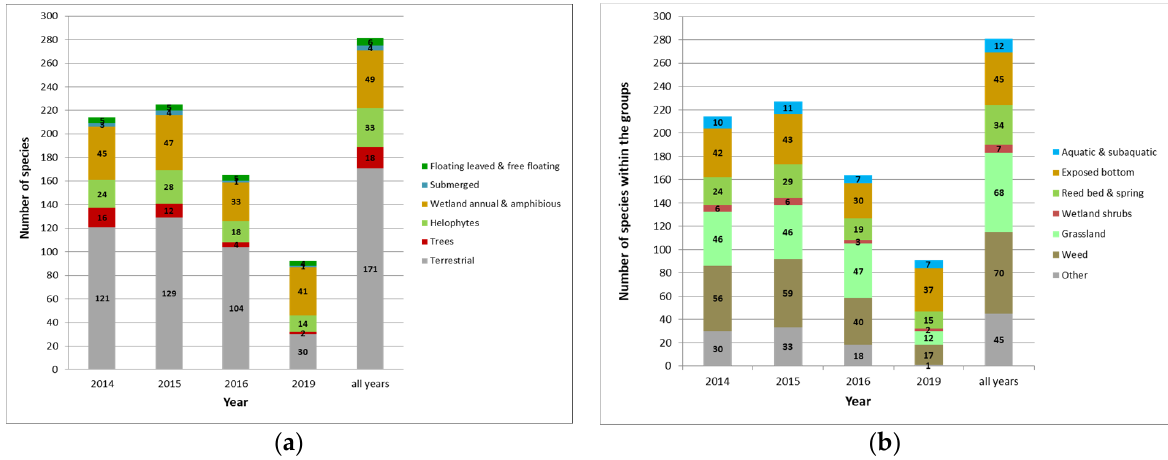
Figure 5. Numbers of plant species according to their ecology and life-history traits: ( a ) detailed classification of aquatic macrophytes into functional groups based on their position on the moisture gradient and life-history traits; all terrestrial species are included into a single group; ( b ) classification of all vascular plant and charophyte species into the groups according to their habitat and/or vegetation preferences. For a detailed description of each species group and classification of particular species, see Table